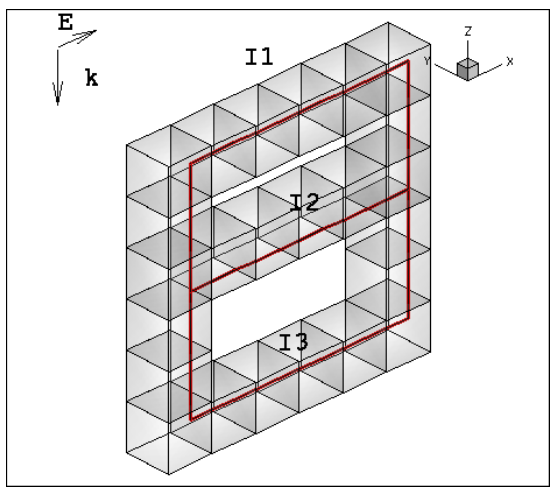
Figure 11: Double loop configuration.